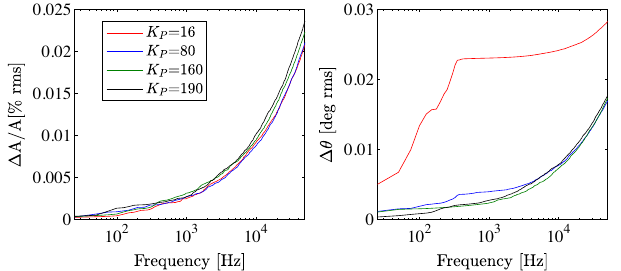
FIG. 10. Cumulative RMS amplitude (left) and phase (right) stabilities of ML1 under different K P .